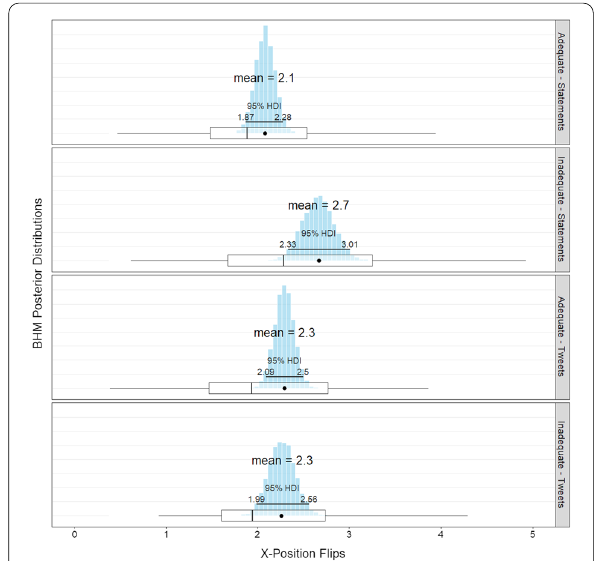
Fig. 7 X-position flips—posterior distribution estimates. The blue histograms represents the mean’s posterior distribution. On top is the most likely mean value based on the BHM. In the middle is the 95% highest density interval. At the bottom is a box plot based on the raw data averaged by participant (the black dot represents the raw